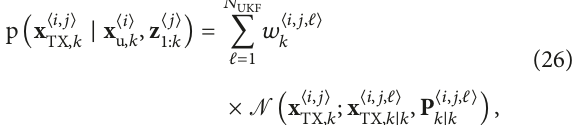
u transmitter states TX Gaussian distributions N ℓ with UKF